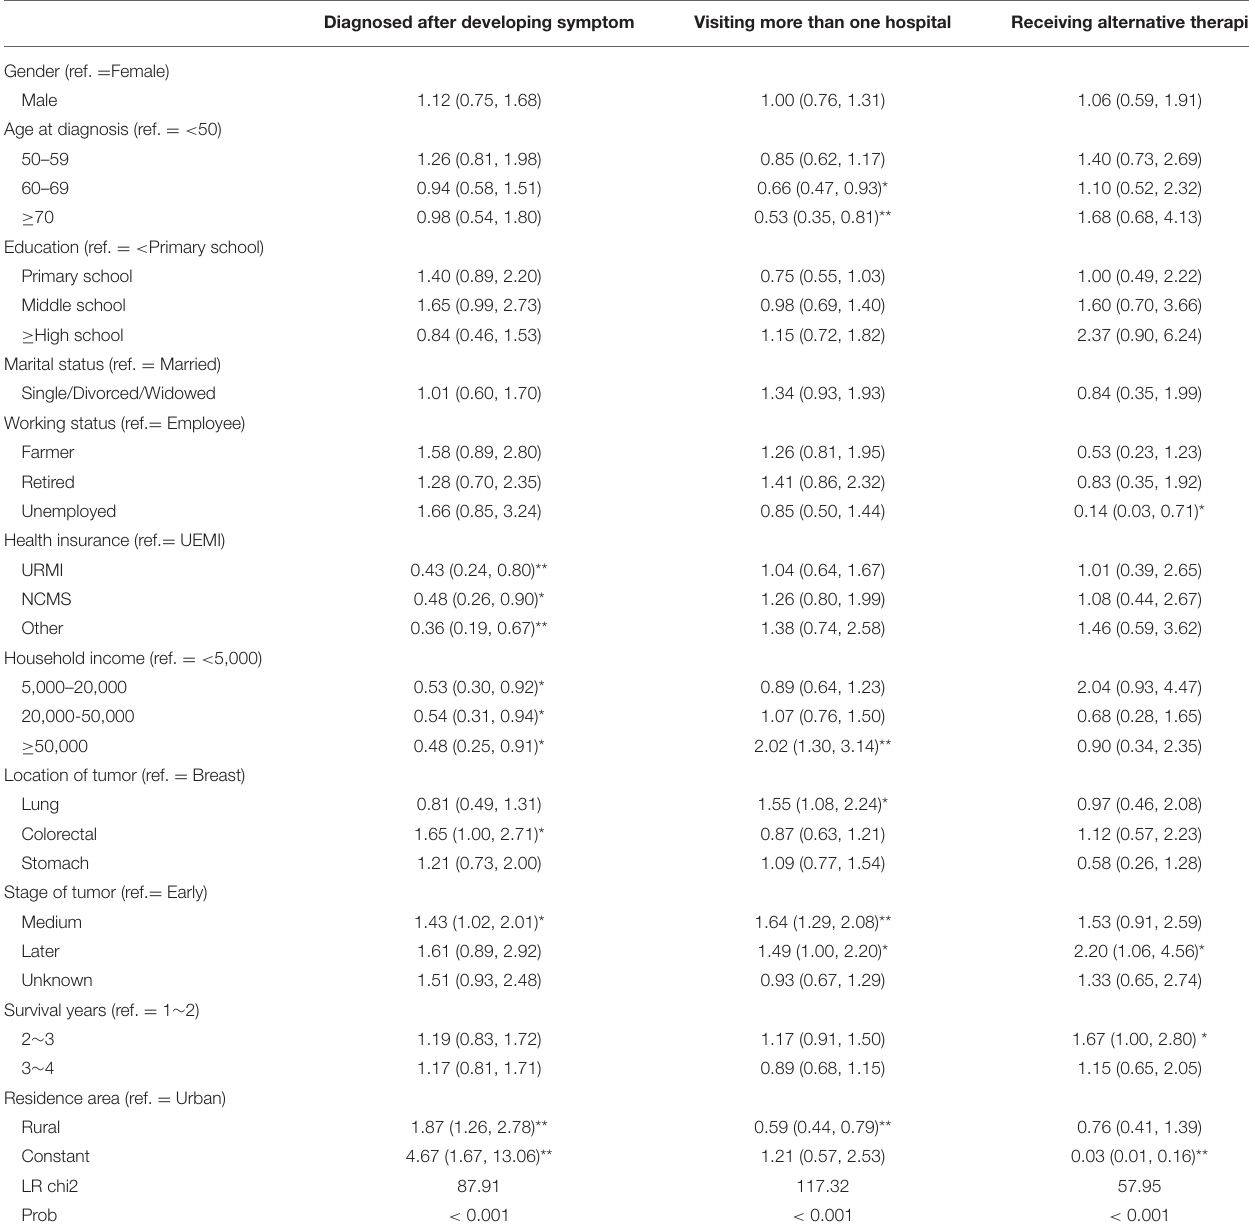
TABLE 3 | Determinants of health care utilization by binary logistic regression (OR, 95%CI). Diagnosed after developing